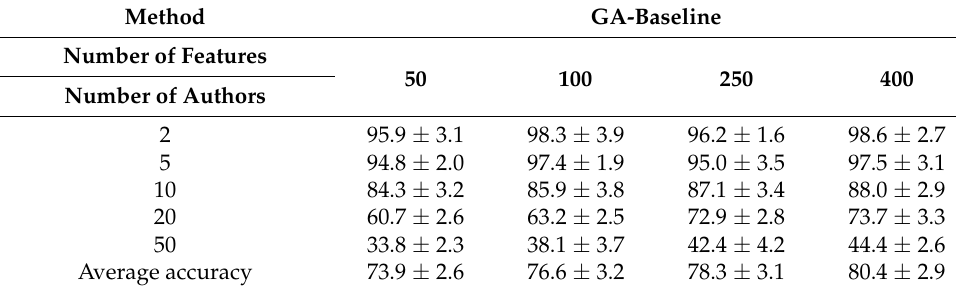
Table 3. Feature selection methods (GA-baseline).